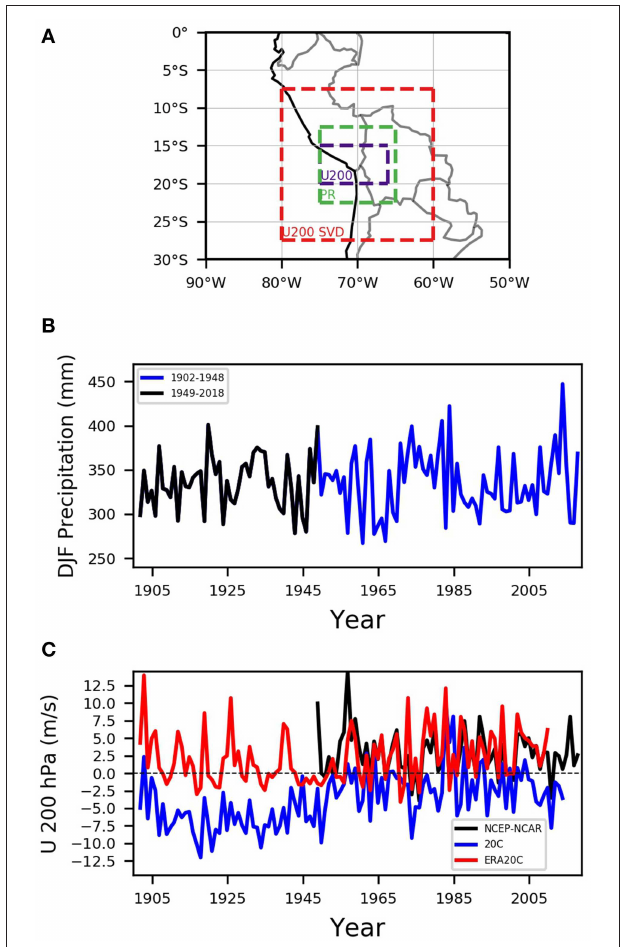
FIGURE 1 | (A) Regions identified for the analysis: Central Andes region from Segura et al. (2016) (purple box), region used to compute SVD for precipitation anomalies in Altiplano (green box) and region considered to compute SVD for U200 anomalies (red box). (B) Temporal evolution of DJF precipitation anomalies, derived from GPCC dataset, in the Altiplano region. Black line indicates 1902–1948 period and blue line indicates 1949–2018 period. Units in mm. (C) Temporal evolution of DJF U200 anomalies, computed from NCEP-NCAR (black), 20C (blue), and ERA20C (red) reanalyses over the purple box displayed in (A) . Units in m/s.